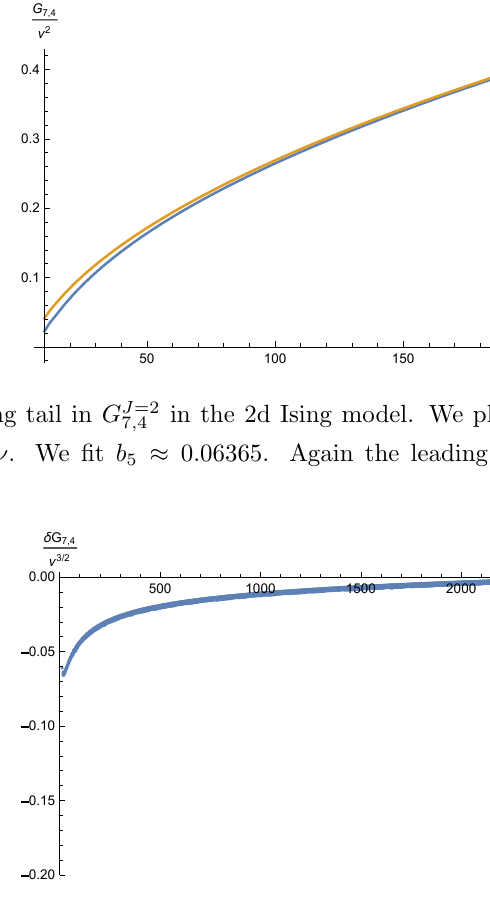
Figure 11 . Error estimate for 1 G 7 ; 4 in the 2d Ising model. We multiply the di(cid:11)erence between the (cid:23) 2 p l.h.s. and the r.h.s. in (6.14) by (cid:23) . Again we get that the error is consistent with the expectation, though convergence in this case is